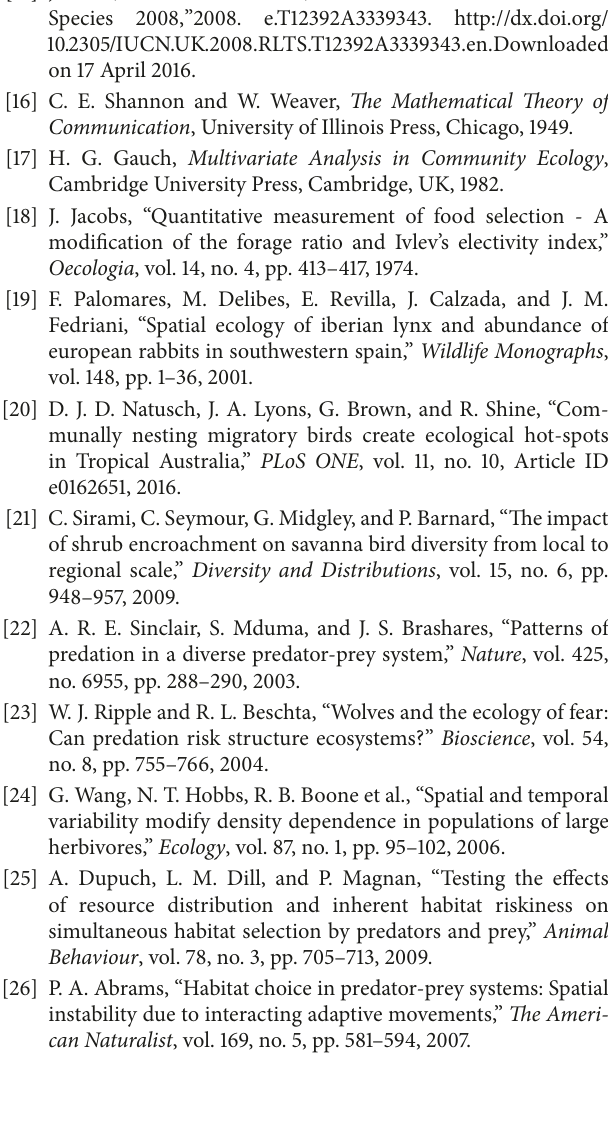
Table 1. Wildlife species detection or nondetection across the various habitat cover types. (Supplementary